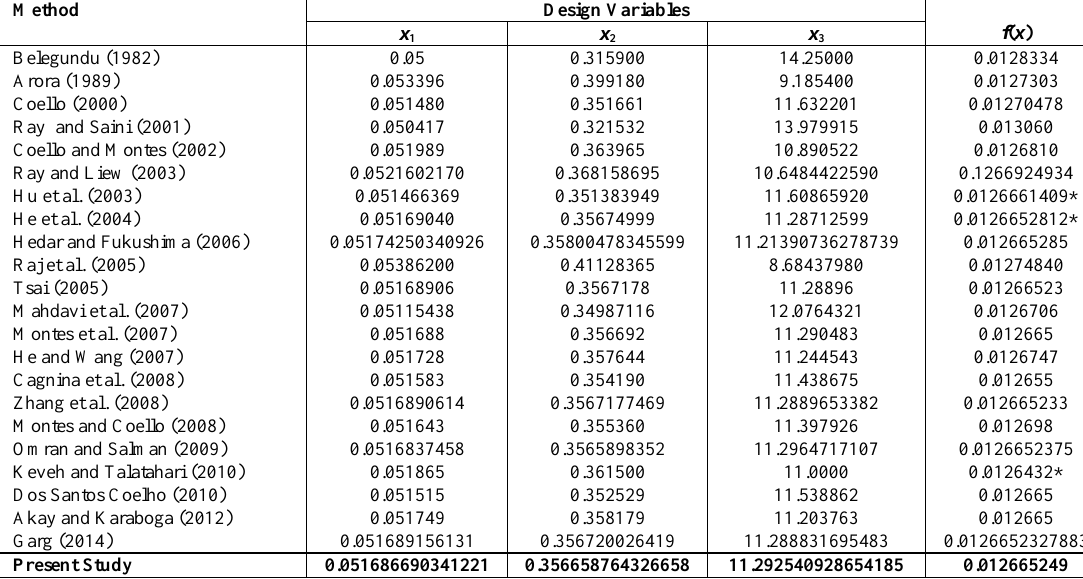
Table 5. Comparison of the best solution for tension/compression string design problem by different